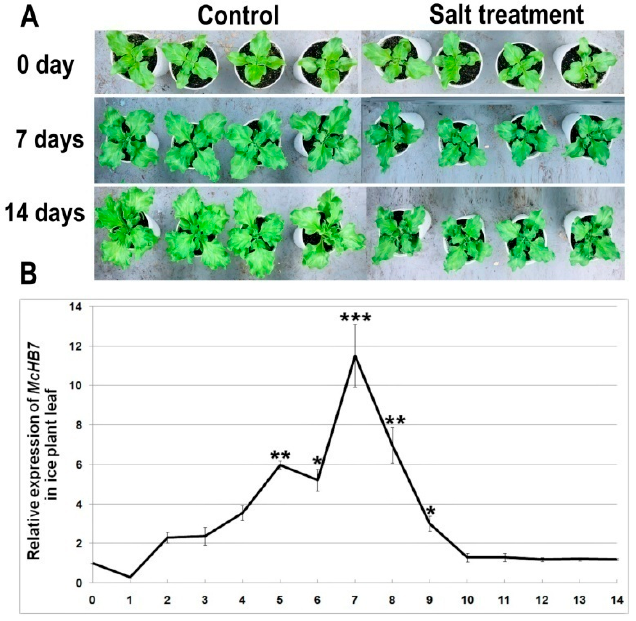
Figure 3. Ice plant growth phenotype and McHB7 expression after high salinity treatment. ( A ) Phenotype of ice plant seedlings under 500 mM NaCl treatment for 0, 7, and 14 days. ( B ) Relative expression of McHB7 after 500 mM NaCl treatment (compared with the control condition). Student’s t -test: t : * p < 0.05; ** p < 0.01, *** p < 0.001, error bars indicate mean ± standard deviation (SD) ( n = 4).